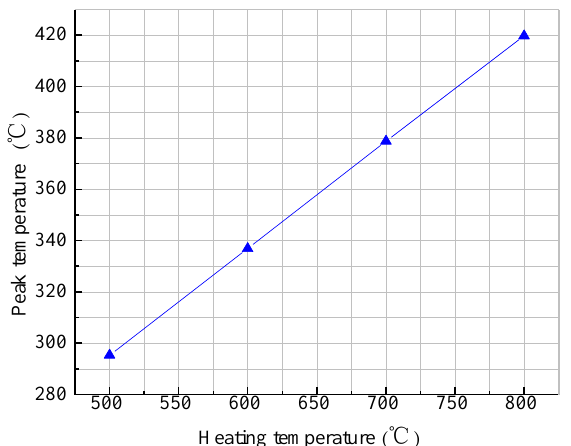
Figure 7. Variation curve of the peak temperature in the first layer under different heating temperatures.